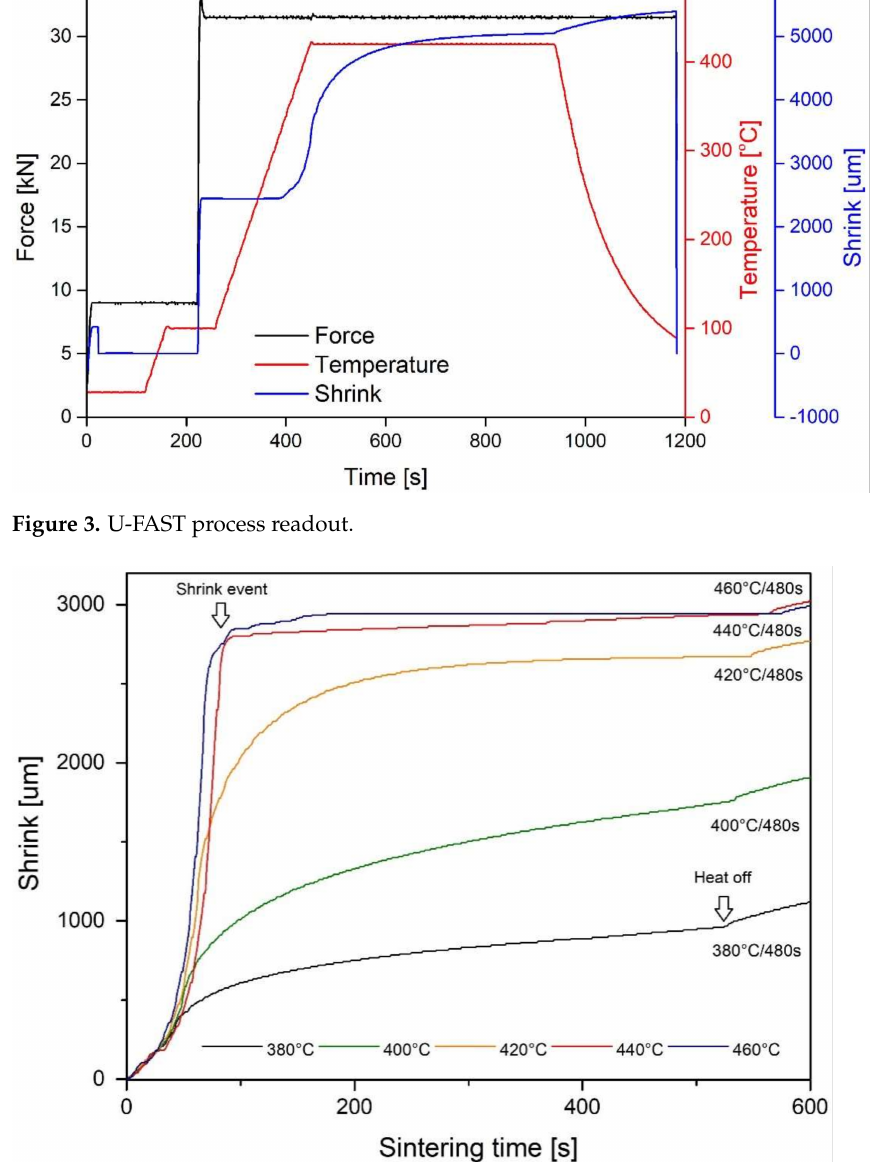
Figure 4. Punch displacement for 480 s sintering